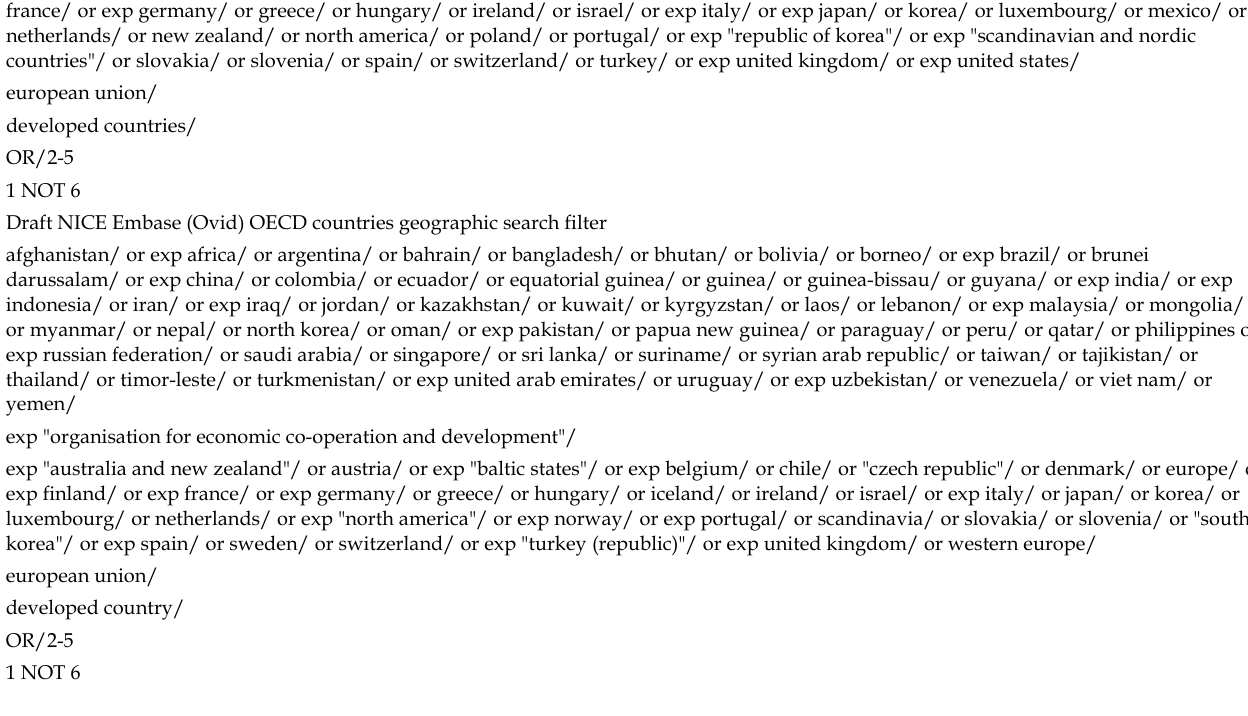
Table 1 Draft NICE MEDLINE OECD countries filter results NICE